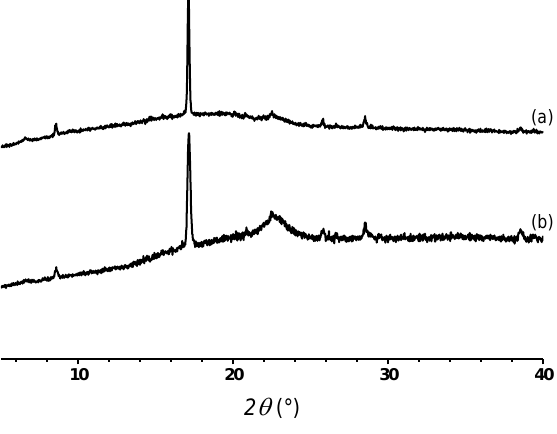
Figure 7. XRD patterns of EM3 ( a ) and EM4 ( b ).